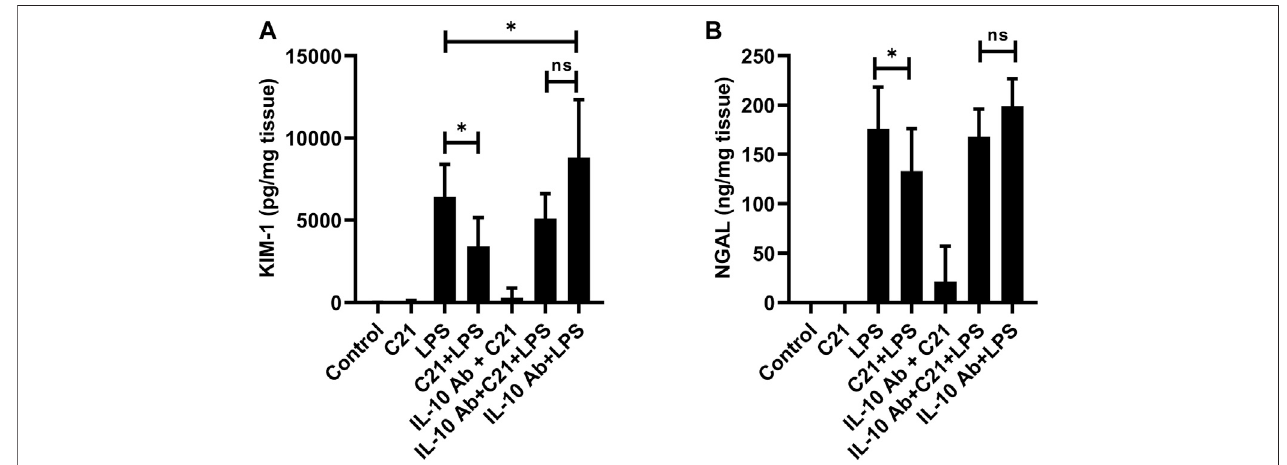
FIGURE 7 | Measurement of renal tubular injury markers (A) KIM-1 and (B) NGAL following 24 h LPS challenge in C57BL6/NHsd mice treated with C21, LPS, or bothwithandwithoutneutralizingIL-10antibody.Dataarerepresented asMean ± S.E.M.,analyzedbyone-wayANOVAwithFisher ’ sLSDtestformultiplecomparisons and are considered signi fi cant at * p <